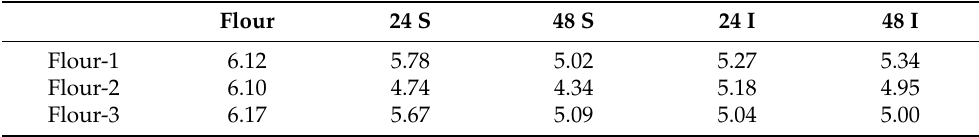
Table A2. Influence of fermentation on the pH value in three chickpea sourdoughs from Flour-1, Flour-2 and Flour-3, prepared by spontaneous fermentation (S) and inoculated fermentation with commercially available starter (I) after 24 h and 48 h of fermentation at 30 ◦